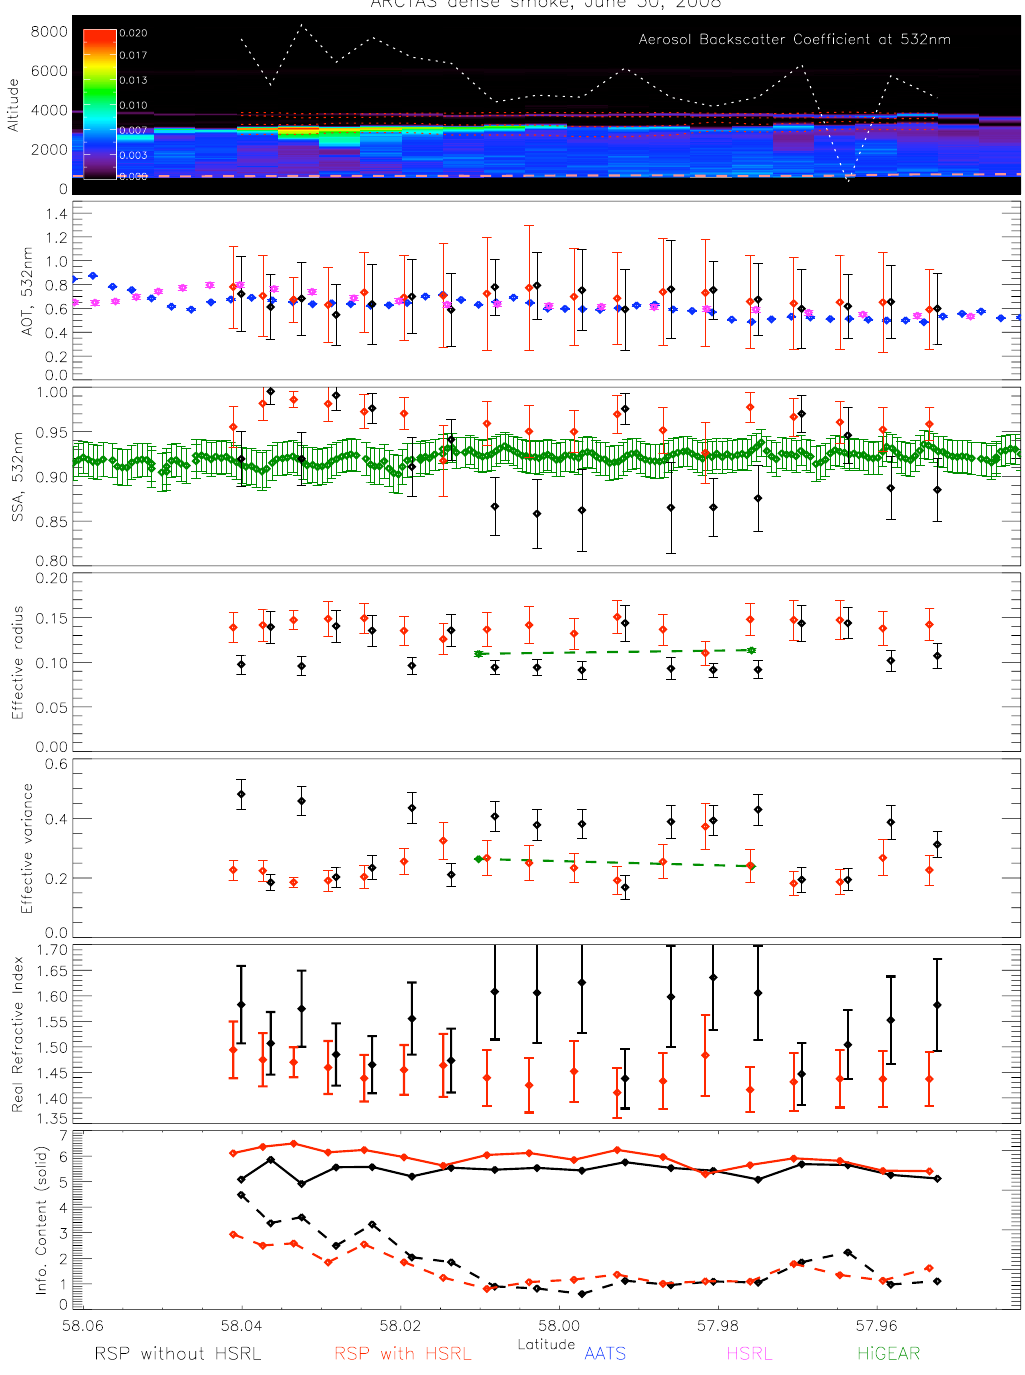
Fig. 3. RSP, HSRL, AATS and HiGEAR data are plotted with respect to latitude (aircraft were flying to the South). The top panel shows the HSRL aerosol backscatter coefficient at 532nm. The dashed white line is the retrieved aerosol layer height for RSP observations that did not include HSRL data. Dashed red lines indicate the HSRL determined aerosol layer heights used for RSP retrievals that used HSRL data. The orange dashed line indicates the altitude of the P-3 aircraft, which carried the AATS and HiGEAR instruments. The second panel is the total aerosol optical thickness at 532nm for RSP retrievals without HSRL data (black), RSP retrievals with HSRL data (red), AATS (blue) and HSRL (magenta). That color scheme is maintained for the rest of the panels, with green indicating HiGEAR data in the third, fourth and fifth panels (Single Scattering Albedo, Effective Radius and Effective Variance, respectively). The sixth panel, with real refractive index, contains RSP data alone, indicating the validation difficulty of this parameter. Finally, the bottom panel is the information content (solid lines) and squared retrieval error (dashed lines) for the two RSP optimization